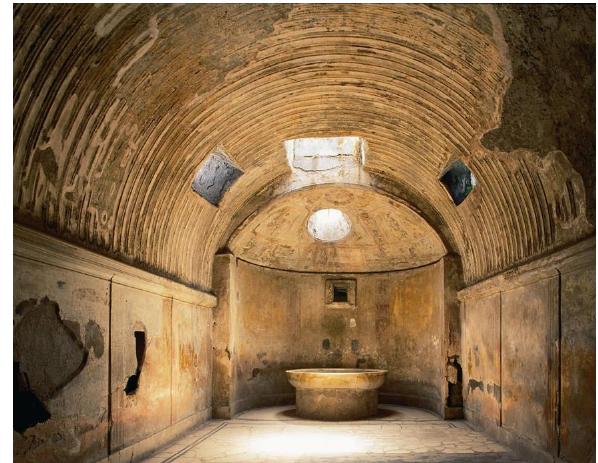
Figure 5. Forum Baths, ‘calidarium ’ of the men's department roofed by a concrete barrel vault covered with